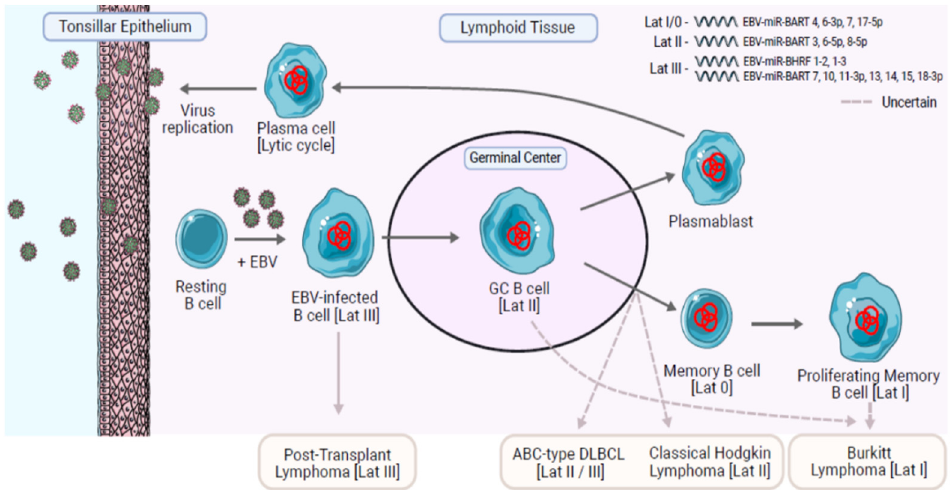
Figure 1. A model to explain the life cycle of EBV in B cells and the origin of EBV-positive B cell lymphomas. Trafficking B cells are presumed to become infected as they pass close to epithelium, potentially in the tonsils. The infected B cells probably then undergo proliferation driven by the Latency III virus gene expression program. The infected B cells enter a germinal center reaction in which only the EBNA1, LMP1, and LMP2A viral proteins are expressed (Latency II). LMP1 is a CD40 homologue and LMP2A is a B cell receptor (BCR)-mimic. Together LMP1 and LMP2A are thought to provide the signals necessary for the EBV-infected cells to survive a germinal center reaction and to differentiate into memory B cells and plasma cells. Plasma cells replicate the virus leading to the release of new virions, which can pass out into the oropharynx for infection of other susceptible hosts. Memory B cells provide the vehicle for long-term virus persistence and are characterized by an absence of virus protein expression (Latency 0). Memory B cells may switch on EBNA1 expression when they proliferate (Latency I). Distinct patterns of miRNA expression in ‘normal’ EBV-infected B cells are associated with Latency III and the other restricted forms of latency II/I/0 (listed in top right of figure). Latency I/0 is characterized by a strong expression of EBV BART4, 6-3p, 7 and a significantly higher expression of miR-17-5p compared to latency II showing modest level of EBV BART3*, 6-5p, and 8-5p. Latency III is characterized by intermediate level of EBV BART7*, 10, 11-3p, 13*, 14*, 15, 18-3p, and EBV-miR-BHRF1-2, 1-3, not expressed in the other forms of latency. The origin of the EBV-associated B cell lymphomas remains uncertain. Assumptions of origin are based largely on resemblance to normal B cell phenotypes and virus latency programs. BL tumors phenotypically resemble normal GC B cells and are probably derived from this stage of B cell differentiation. However, because BL usually expresses a Lat I phenotype, it has been suggested by others that BL could be derived from proliferating memory B cells. Figure made with Servier Medical Art. 2021. SMART—Servier Medical ART (online). Available online: https://smart.servier.com/, accessed on 5 July